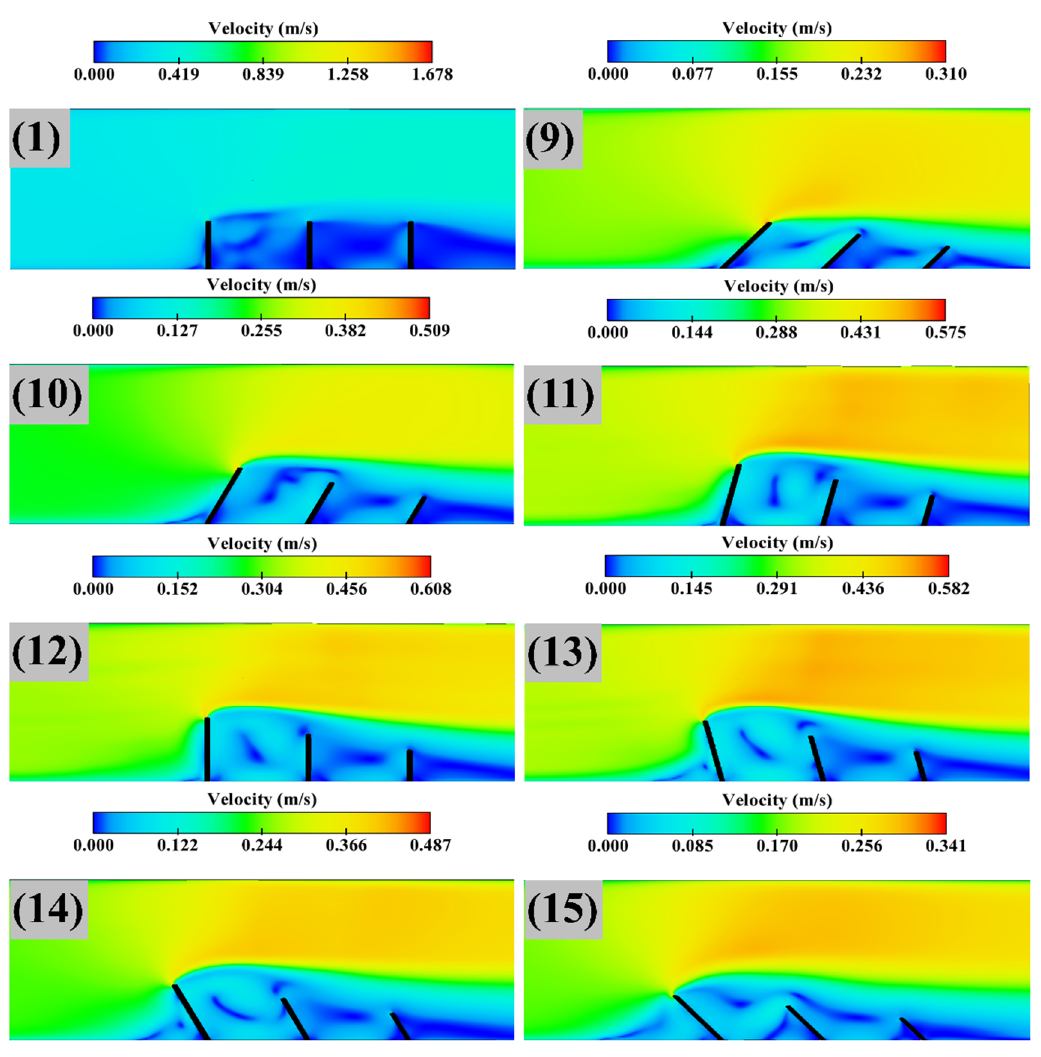
Figure 15. Velocities in simulations 1 and 9–15.